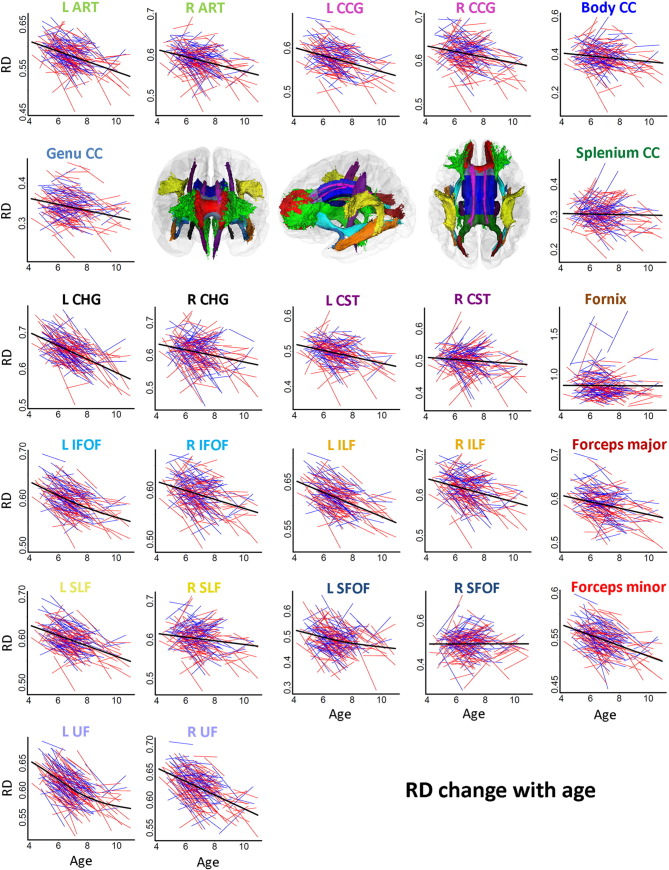
Spaghetti plots of change for RD in specific tracts with age.Spaghetti plots of individual participant change in RD in specific tracts with age (years). Females are plotted in red and males in blue. For each measure, an assumption-free general additive mixed model as a function of age was fitted to accurately describe changes across the age range. Diffusivity values RD are in 10-3 x mm2/s. Diffusivity values RD are 10− 3 x mm2/s. Three-dimensional renderings of the probabilistic tracts illustrate fifteen atlas-based probabilistic tracts from the Mori as for Fig. 3.